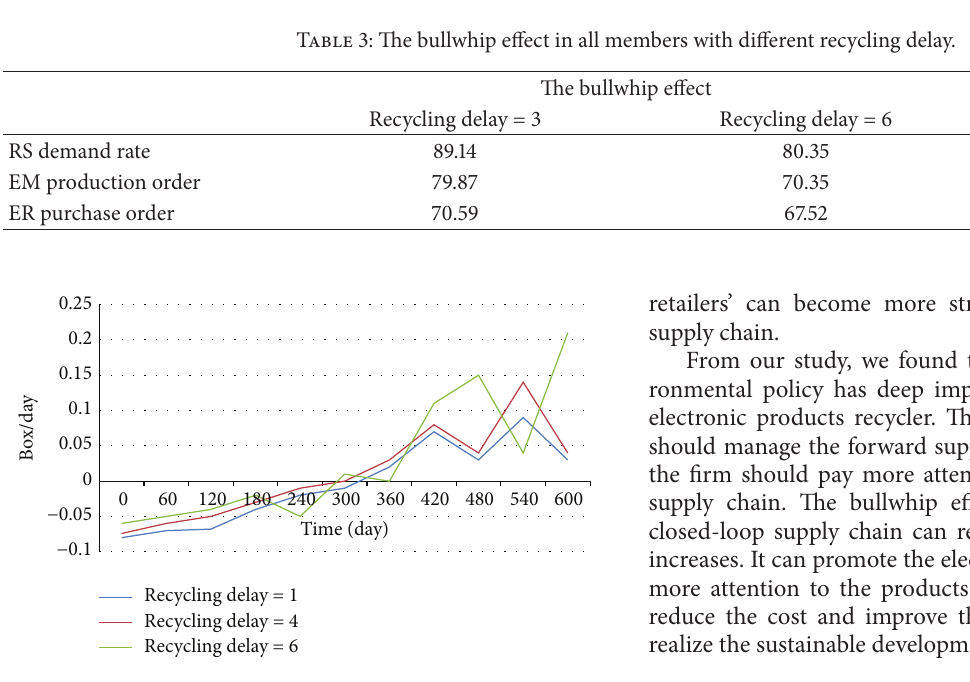
Figure 7: The third-party recycler’s recycling ratio in different recycling